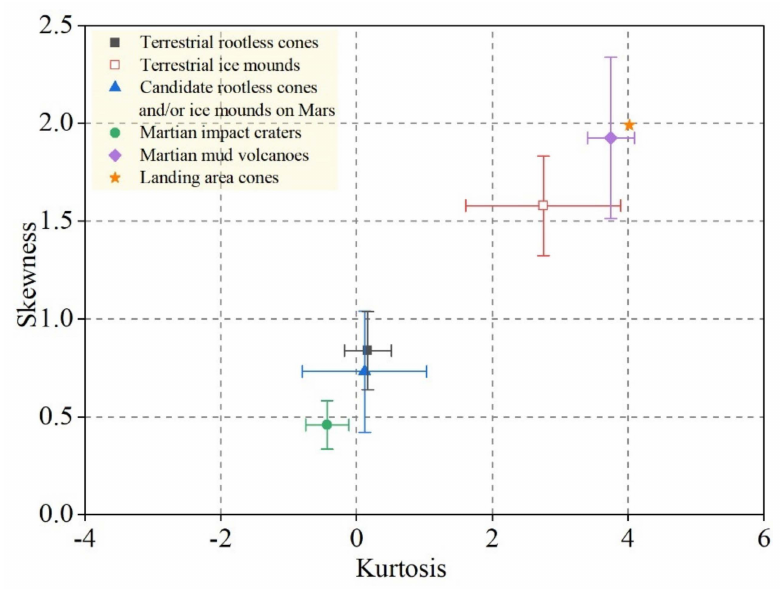
Figure 9. The result of skewness − kurtosis analysis. The error bars are 2 standard errors of the mean. Except for the landing area cones and Martian mud volcanoes, all the other data are from [41]. We calculated the values of Martian mud volcanoes based on their spatial location data from [3,5]. Note, Burno et al. [41] used “ice mound” to replace